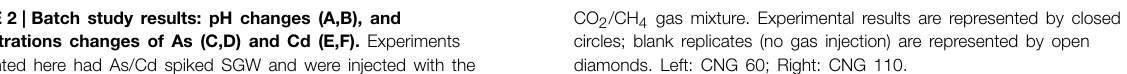
FIGURE 2 | Batch study results: pH changes (A,B), and concentrations changes of As (C,D) and Cd (E,F). Experiments represented here had As/Cd spiked SGW and were injected with the